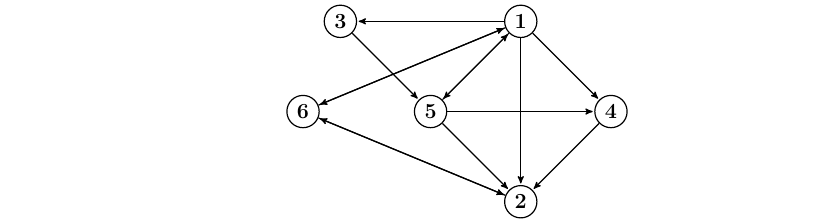
Figure 4: Strongly connected D ( a